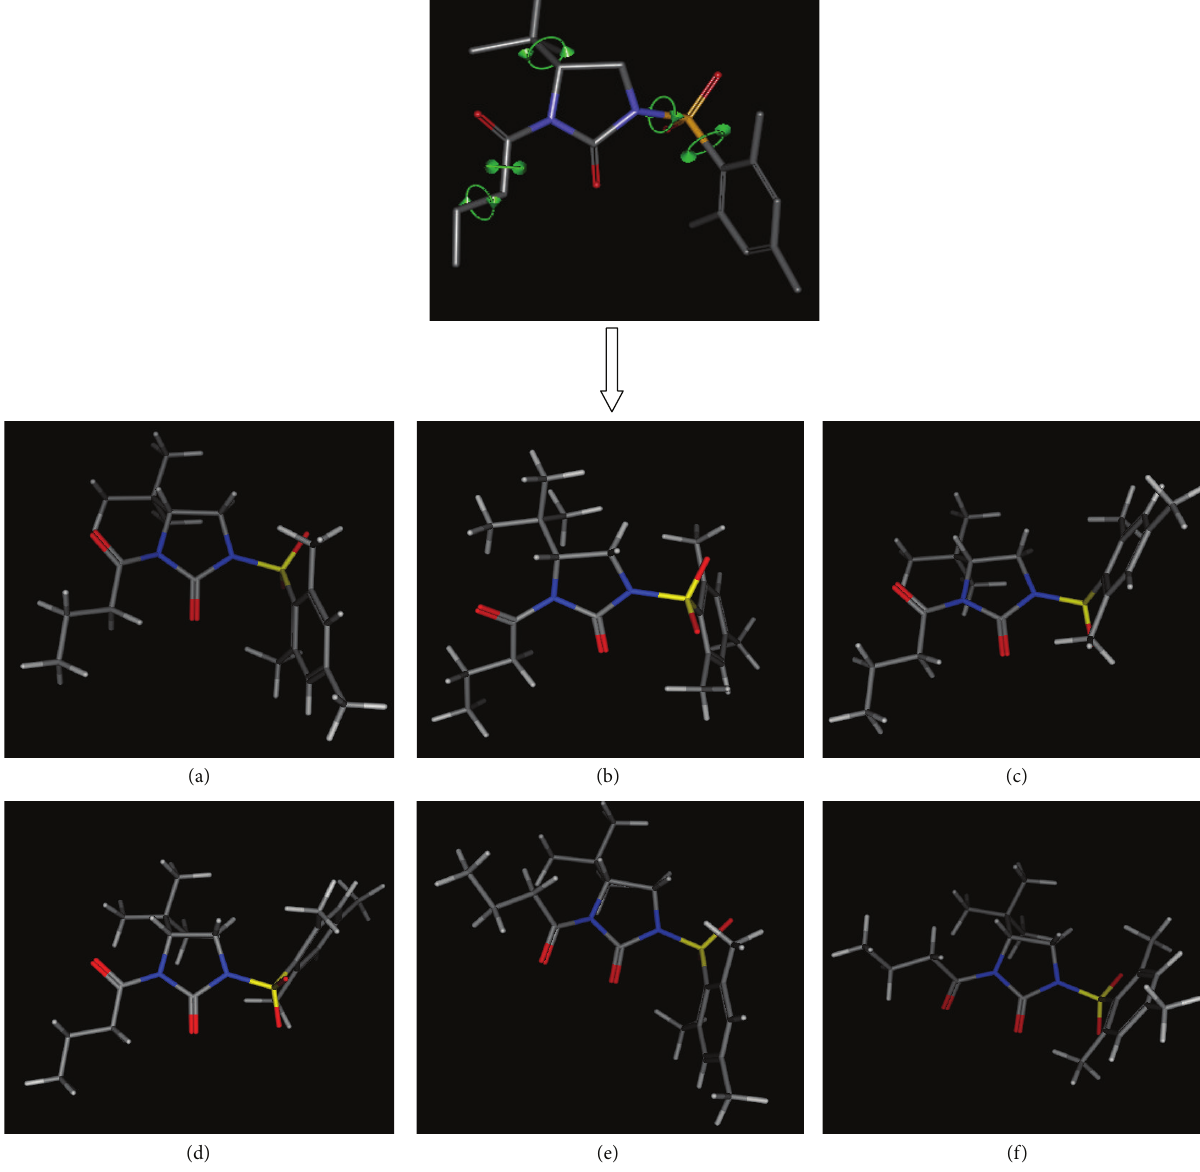
Figure 4: Results of conformational search showing most stable energy minimum: conformer - A (a), conformer - B (b), and the least stable conformers, including conformer - C (c), conformer - D (d), conformer - E (e), and conformer - F